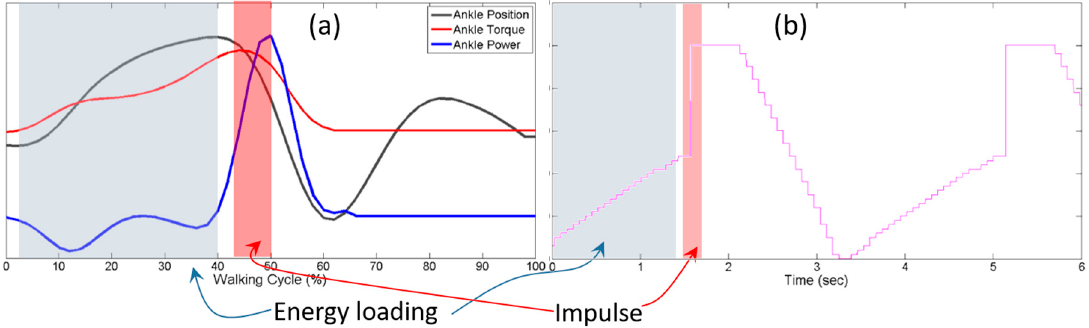
Figure 9. Trajectory logic to emulate the ankle with energy loading and impulse regions highlighted. ( a ) Ankle data from CGA. ( b ) Implemented trajectory to emulate the ankle torque behavior.